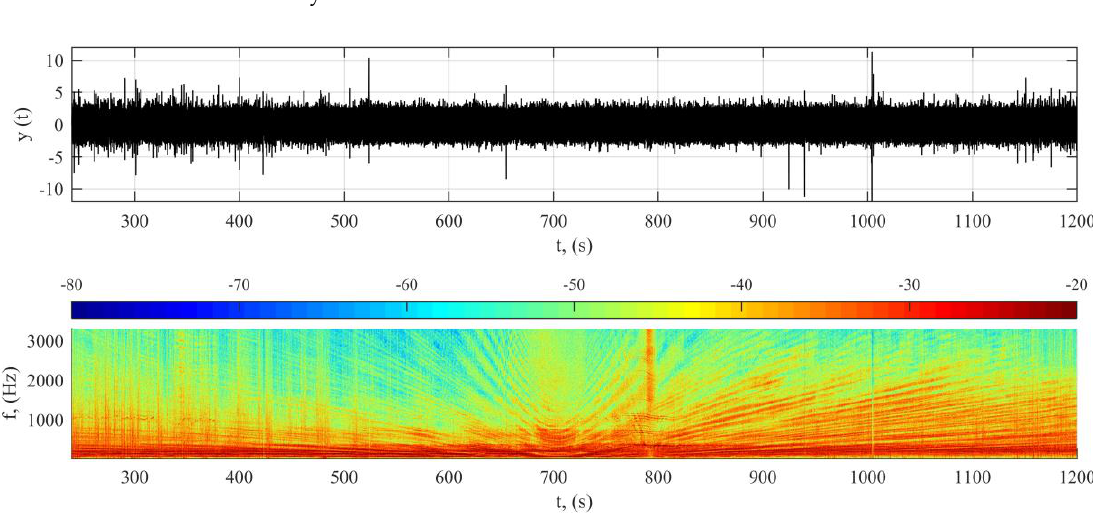
Figure 2. Oscillogram (top) and spectrogram (bottom) with a scale reflecting dependence of color on the levels of spectral components of the signal in dB at the output of program module that is implementing automatic gain control (AGC) and normalization of the signal by the level. The scale is conventional.